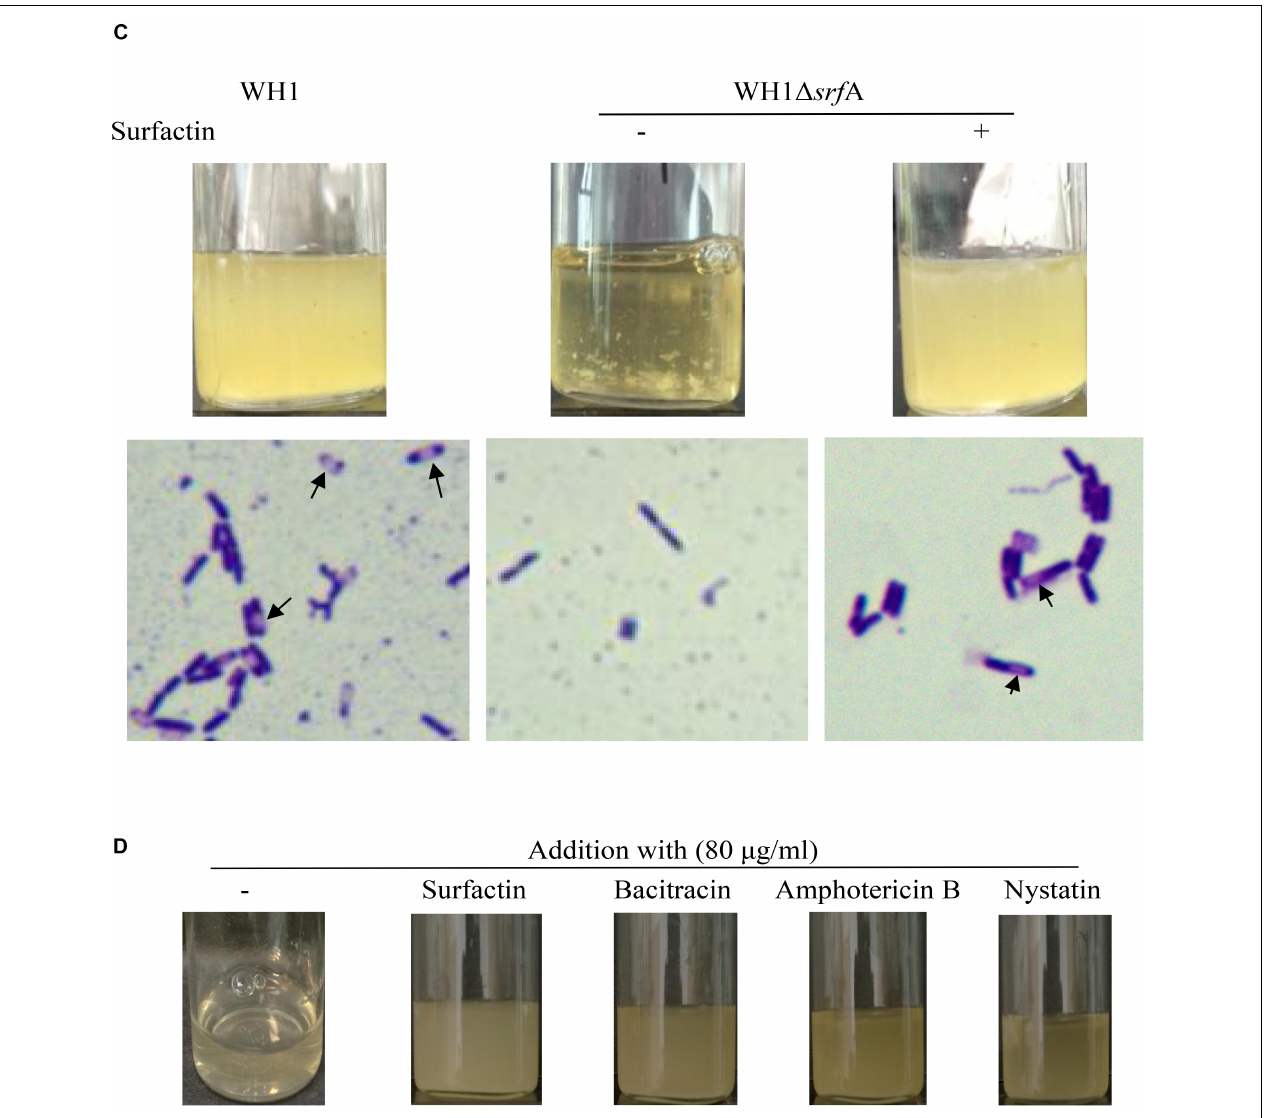
FIGURE 1 | Mutation of srfA resulted in a defective bacterial growth. (A) Growth curves of WH1 and lipopeptide gene mutant strains. Mutation of srfA led to a defective bacterial growth. (B) Cells of WH1 and lipopeptide gene mutant strains (magnification 1000 × ). (cid:49) srfA died after 18 h without sporulation while other strains grew well with sporulation. Arrows indicate the spores. (C) Addition with surfactin dramatically restored the growth and sporulation in (cid:49) srfA (magnification 1000 × ). Spores are indicated by arrows. (D) Addition with bacitracin, nystatin, or amphotericin B partially restored the growth in (cid:49) srfA